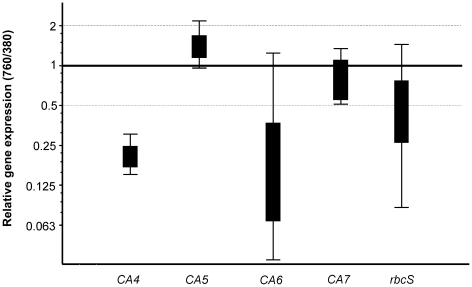
Gene expression of δ-CA and RUBISCO in T. pseudonana grown in pH auxostat continuous culture.qPCR was used to determine the gene expression ratio in cultures grown at 760 µatm pCO2 relative to those grown at 380 µatm pCO2. Boxes represent the inter-quartile range, or the middle 50% of observations. The dotted line represents the median gene expression. Whiskers represent the minimum and maximum observations.